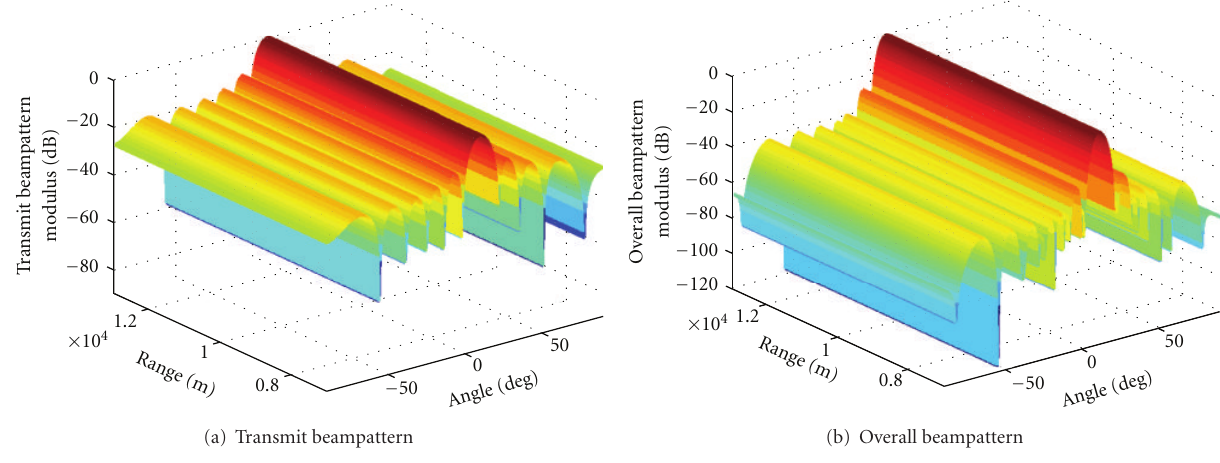
Figure 5: Conventional phased-array beampatterns using conventional